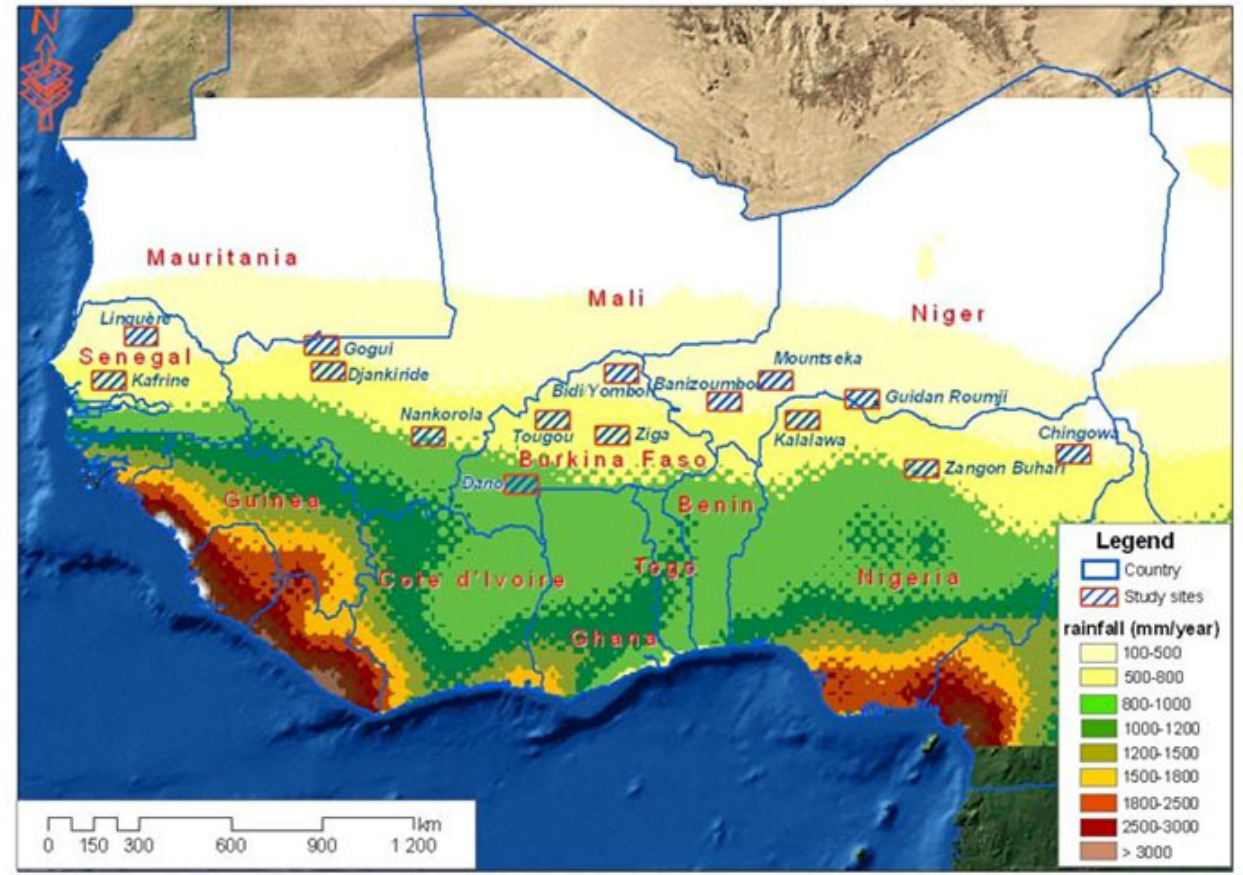
Fig. 1 . Location of field sites in West Africa with isohyets. Source of isohyets: NASA gridded